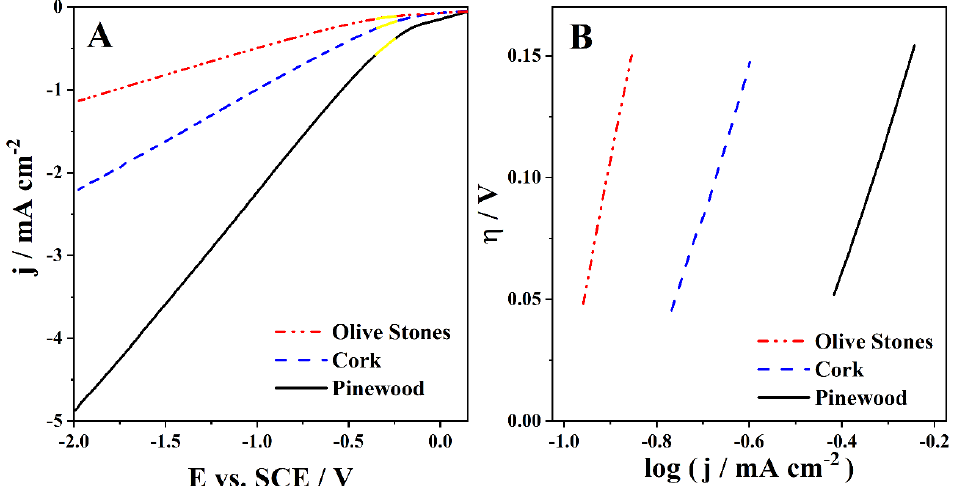
Figure 3. ( A ) Cathodic polarization curves run at 50 mV s − 1 in the cork, pinewood, and olive stones bio-oil samples with 3 M H 2 SO 4 and ( B ) the corresponding Tafel plots.